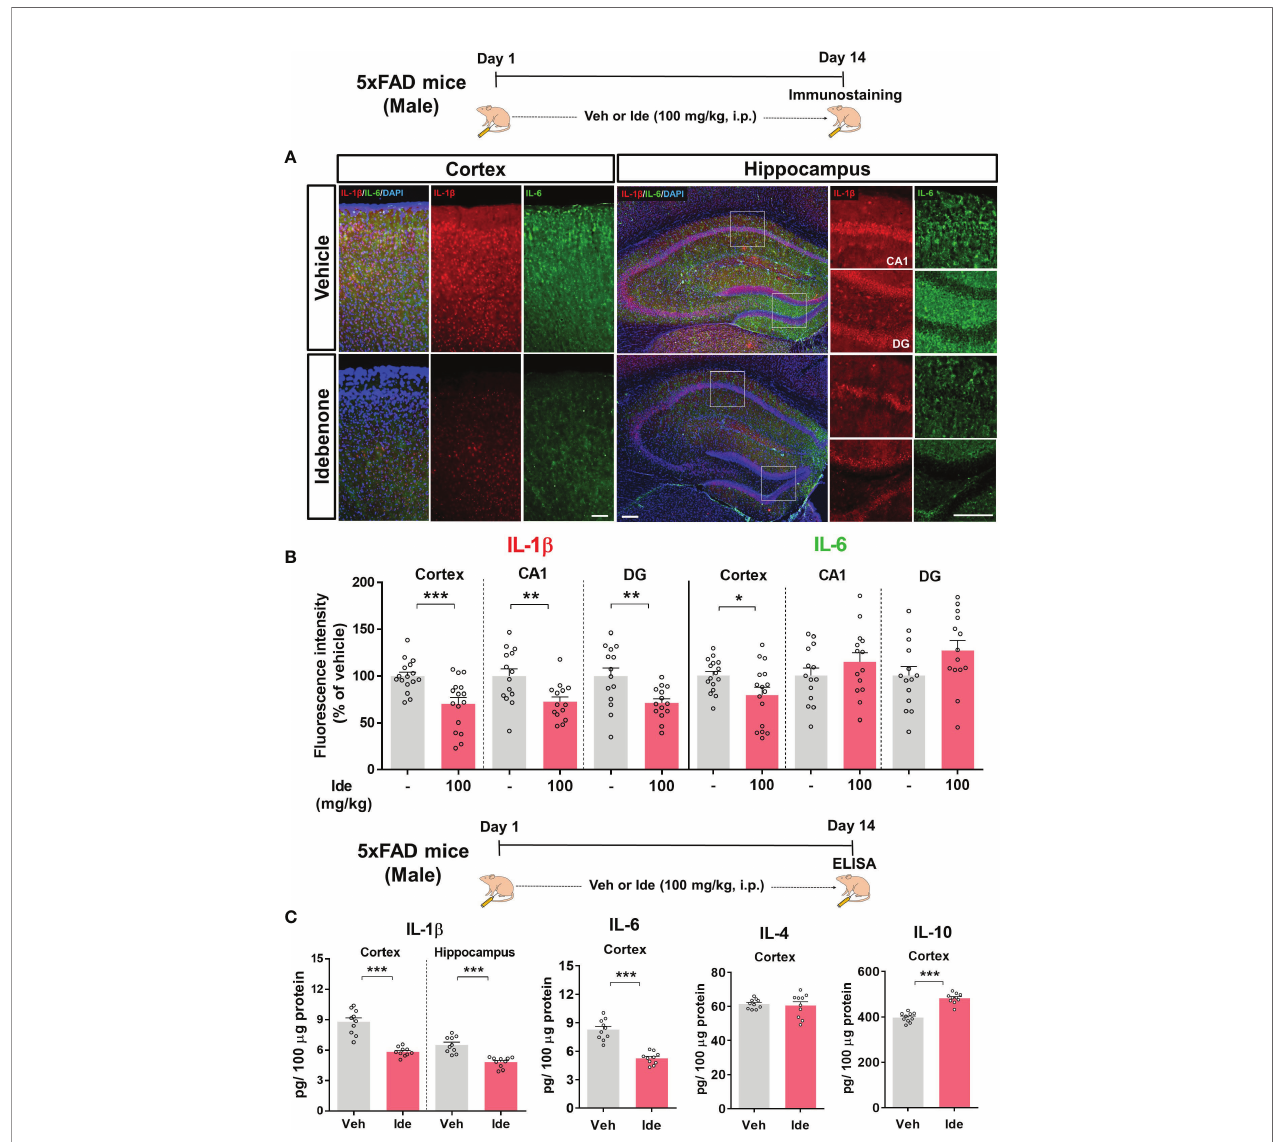
FIGURE 12 | Idebenone modulates levels of the A b -evoked proin fl ammatory cytokines IL-1 b and IL-6 in 5xFAD mice (A) Representative images of IL-1 b and IL-6 immuno fl uorescence in the cortex and hippocampus in 5xFAD mice. (B) Quanti fi cation of the fl uorescence intensity of IL-1 b and IL-6 (n = 14 – 16 brain slices from 4 mice/group). (C) ELISA analysis of IL-1 b , IL-6, IL-4, and IL-10 protein levels in the cortex and/or hippocampus in 5xFAD mice (n = 10 mice/group). *p < 0.05, **p < 0.01 and ***p < 0.001. Scale bar = 200 m